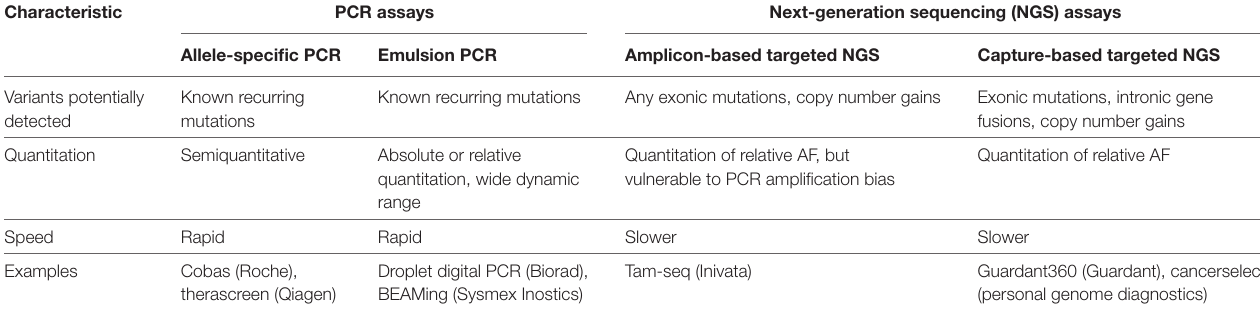
TAbLe 1 | Available assays of detection of circulating tumor DNA (12, 24).